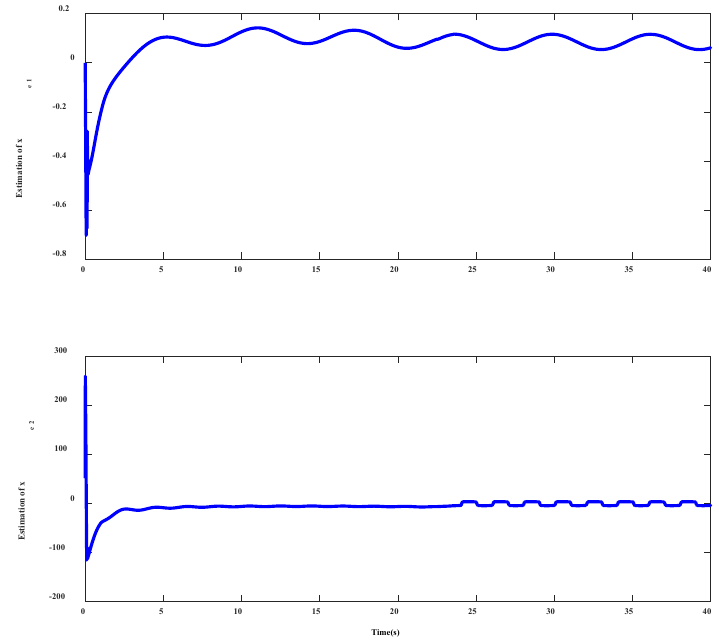
Figure 7. The disturbance estimations of the ADRAC.